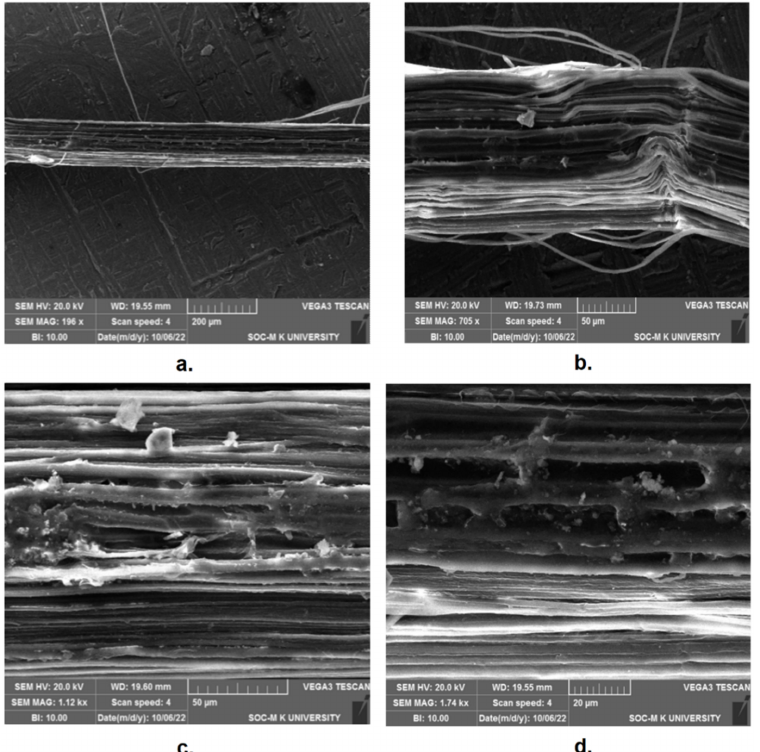
Figure 6. SEM micrographs of PCLF at different magnifications: ( a ) 196x; ( b ) 705x; ( c ) 1.12 kx; ( d ) 1.74